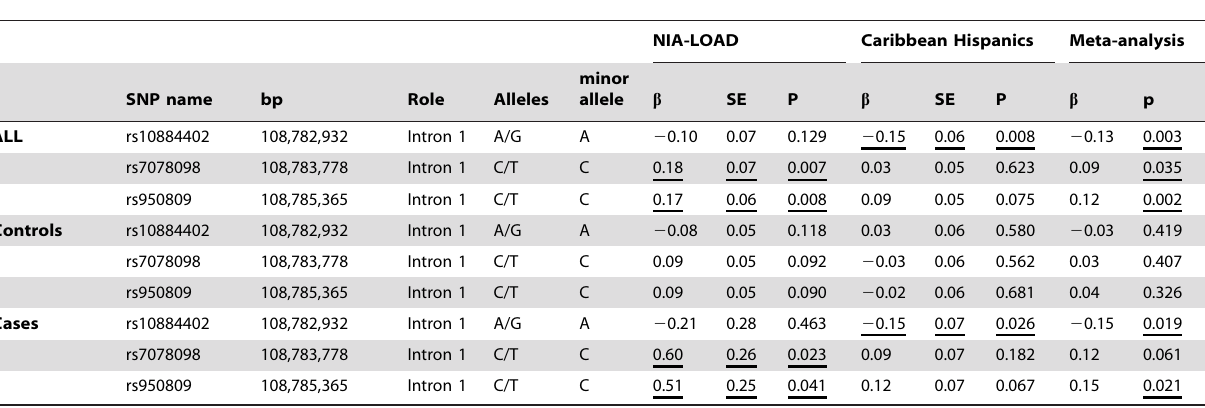
Table 2. Single marker associations of SNPs rs10884402, rs7078098 and rs950809 with the memory savings